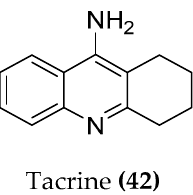
Figure 19. Structure of tacrine.